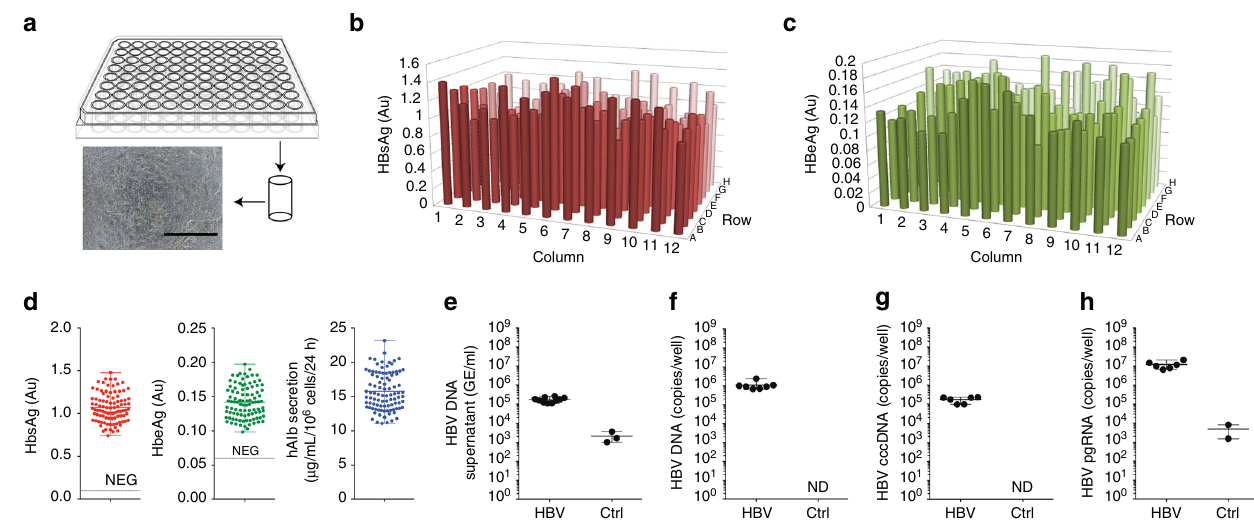
Fig. 4 Robust HBV infection SACC-PHHs in microwell formats. a Schematic depiction and representative bright- fi eld image of the microwell SACC-PHH system (scale bar = 400 μ m). Quanti fi cation of HBsAg b and HBeAg c across the 96-well format at 10 dpi (day 20 post seeding). d Limited variation of HBsAg ( left , mean 1.070 Au, std 0.167 Au, two tail t -test p -value < 0.0001, compared to 1 Au), HBeAg (middle, mean 0.142 Au, std 0.024 Au, two tail t -test p -value < 0.0001, compared to 0 Au) and hAlb (right, mean 15.75 μ gml per 10 6 cells per 24 h, std 2.679 μ gml per 10 6 cells per 24 h, two tail t -test p -value < 0.001, compared to 15 μ gml per10 6 cells per 24 h) at 10 dpi. Quanti fi cation of HBV DNA in culture supernatants e at 10 dpi, and total HBV DNA f , cccDNA g and pgRNA h in cell lysates of randomly picked wells at 30 dpi. For HBV DNA and RNA quanti fi cations six to ten replicates were performed. For HBsAg, HBeAg, and hAlb 96-biological replicates were performed. All data are presented as means ±